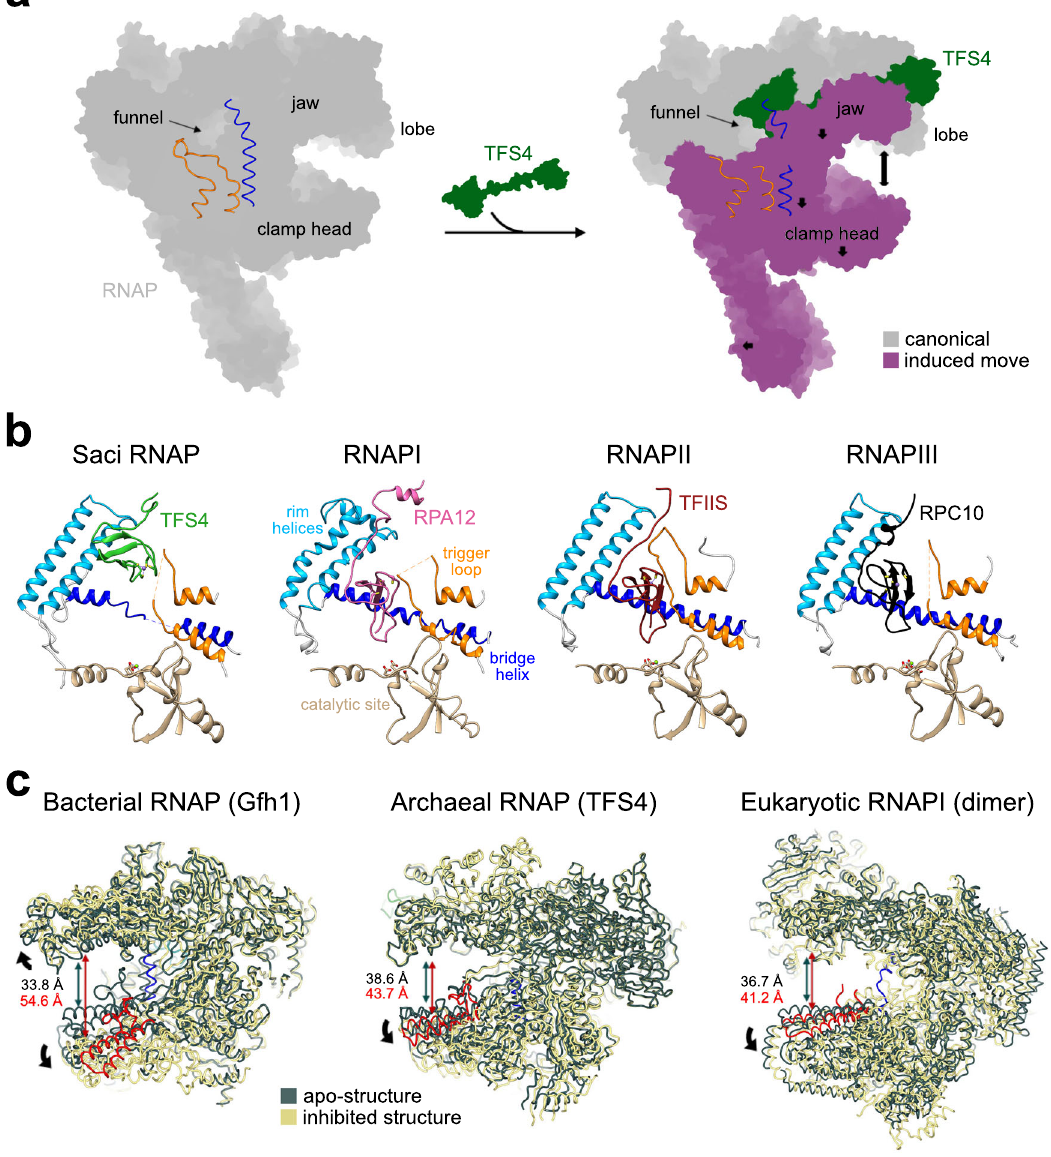
Fig. 7 Commonalities into allosterically exploiting the RNAP structural fl exibility. a Schematic representation of the conformational changes induced by TFS4 binding. The RNAP is shown in grey, and the part of the structure subjected to conformational change is highlighted in purple with the movement direction indicated by arrows. Main features of RNAP including the secondary channel, jaw, lobe and clamp head, as well as bridge helix and trigger loop are indicated. b Comparison of the archaeal Saci RNAP with eukaryotic RNAPI, II and III and the locations of the ZR C domains of subunits TFS4, RPA12, TFIIS, and RPC10 (human homologous of RPC11) (pdb codes 6rqh, 5xon, and 7ae3, respectively for the eukaryotic factors 69 , 70 , 31 ), relative to the rim helices and the active site motifs (aspartate triad, bridge helix and trigger loop). Only the TFS4 ZR C domain is located at the rim of the NTPs-entry funnel and clashes with the trigger loop, while all other ZR C domains reach towards the catalytic magnesium ion (green sphere). c The structural changes associated with the inhibition of the archaeal, bacterial and eukaryotic RNAPI by TFS4, Gfh1, and RNAPI dimerisation, respectively, involve a widening of the DNA binding- channel. The structures of the free, or apo forms of RNAP are shown in dark teal, and the inhibited conformations of the RNAP-TFS4, RNAP-Gfh1 and RNAPI dimers are shown in yellow, respectively. The RNAP clamp helices are highlighted in red and the bridge helix distortions in